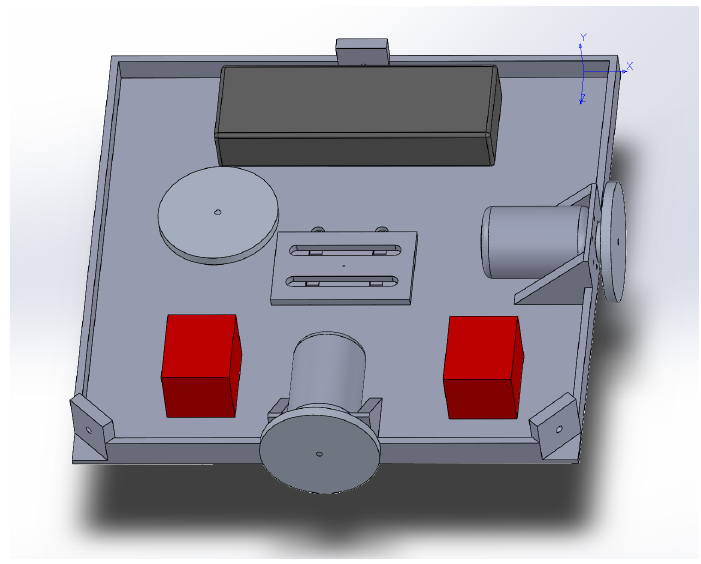
Figure 1. SOLIDWORKS CAD rendering of START.